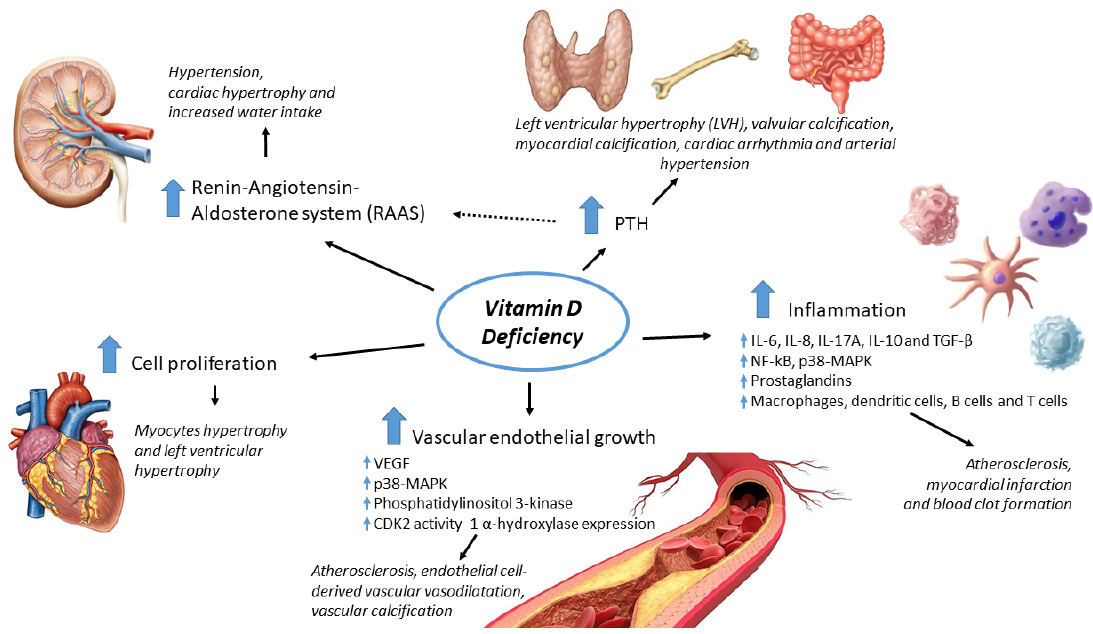
Figure 1. The main mechanisms involved in cardiovascular risk due to vitamin D deficiency.